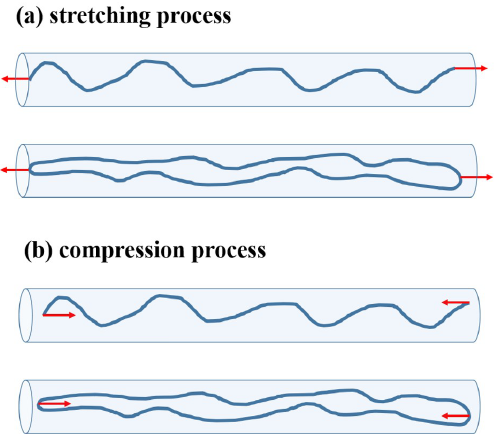
Figure 1. Sketchs of ( a ) the stretching processes and ( b ) compression processes for linear and ring polymers, caused by external forces on two ends or two sides,